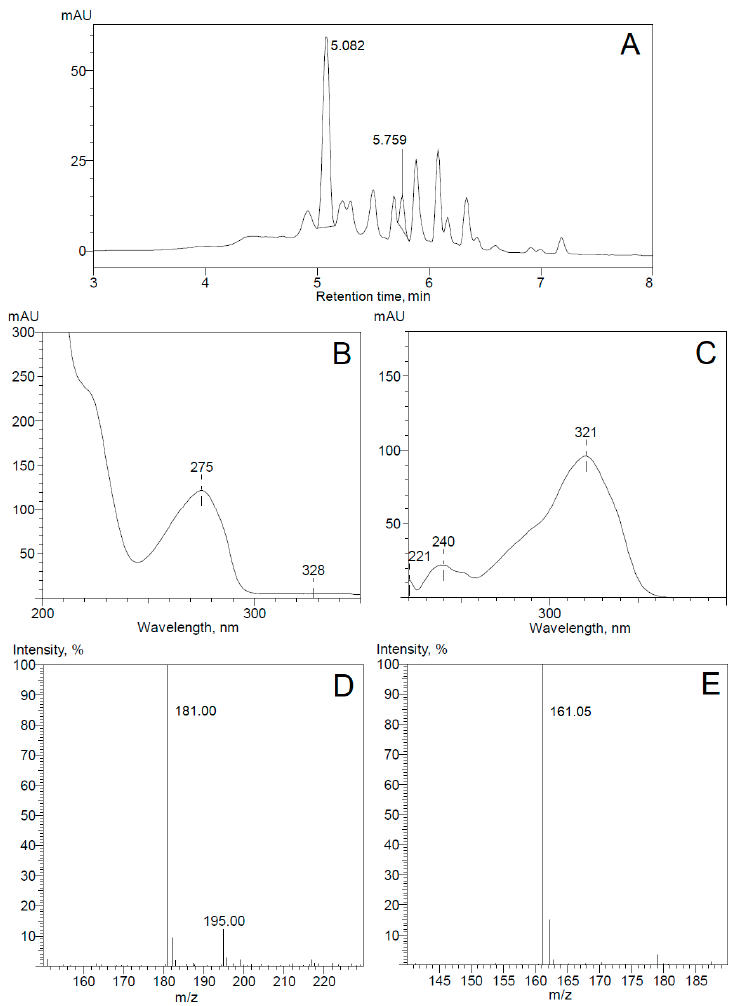
Figure 2. Pseudomonas sp. 7HK4 bacteria were grown in the presence of 7-hydroxycoumarin, and produced metabolites were analyzed by HPLC-MS. UV 254 nm trace of metabolites ( A ). UV and MS spectra of peaks with retention times 5.082 min ( B , D ) and 5.759 min ( C , E ). The negative ions [M − H] − generated are at m/z 181.00 (3-(2,4-dihydroxyphenyl)-propionic acid) and 161.05 (7- hydroxycoumarin).